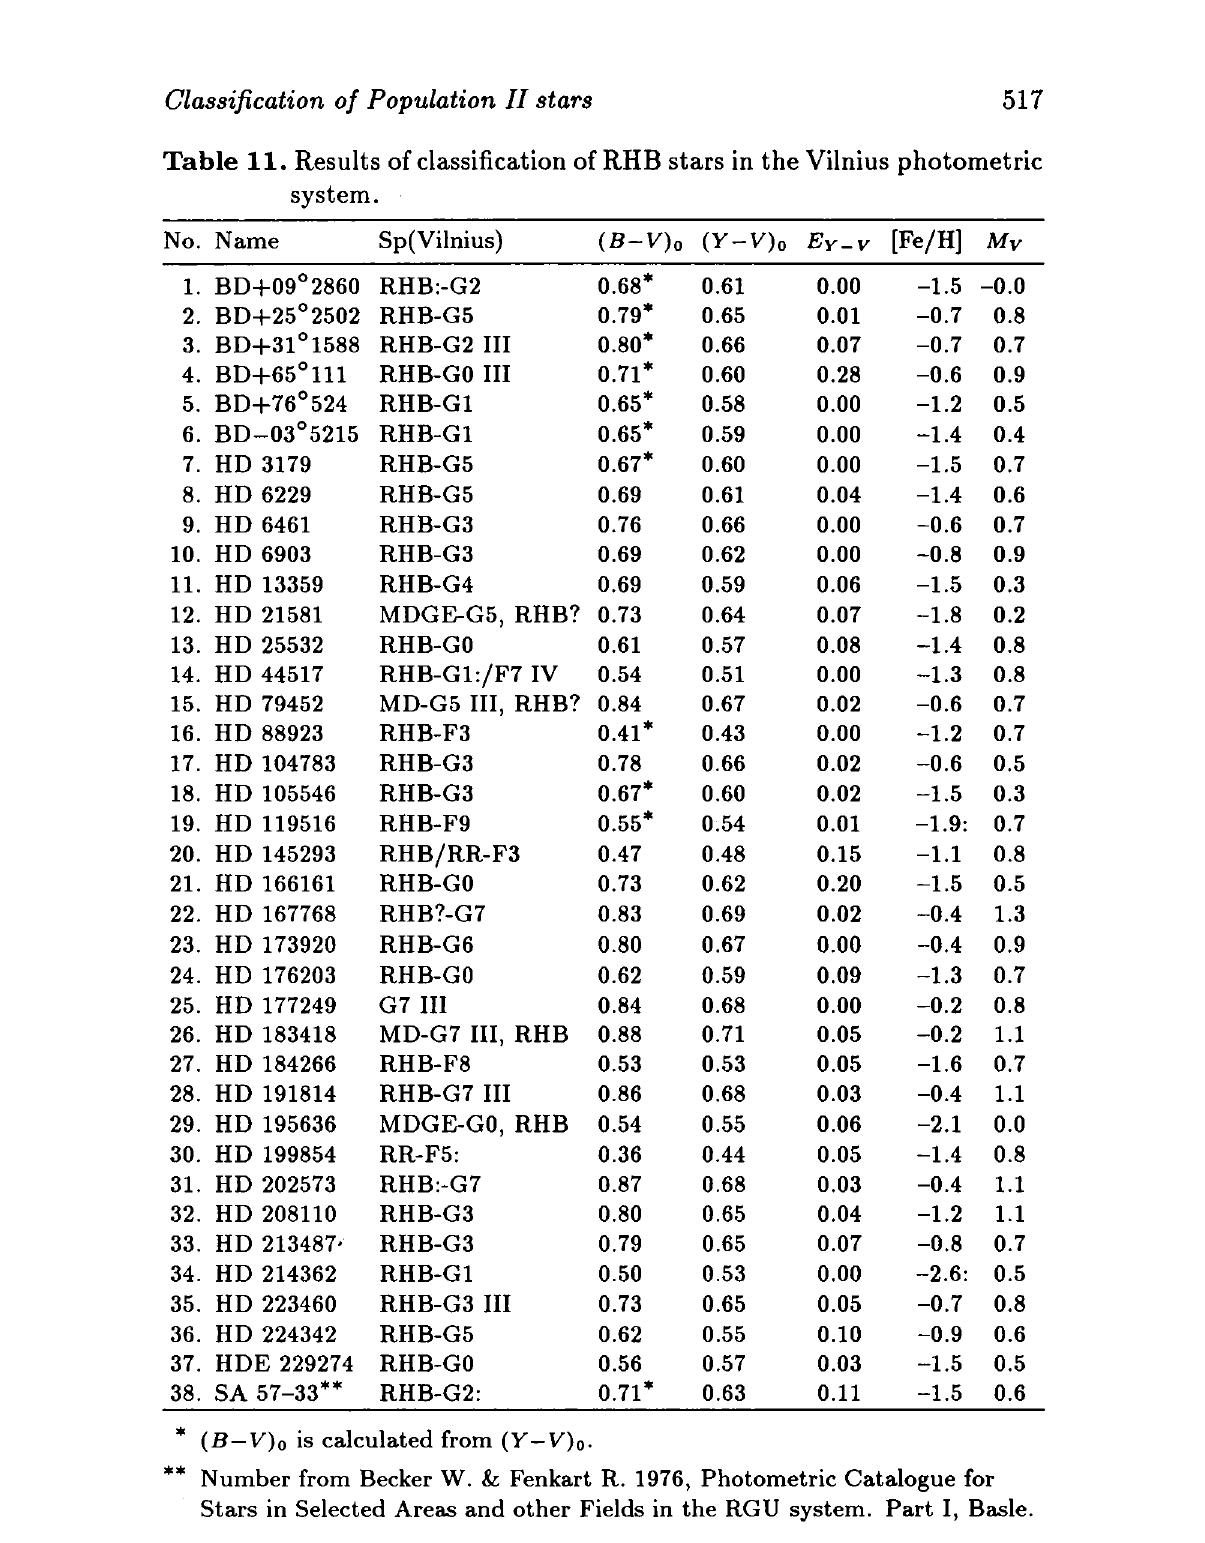
Table 11. Results of classification of RHB stars in the Vilnius photometric